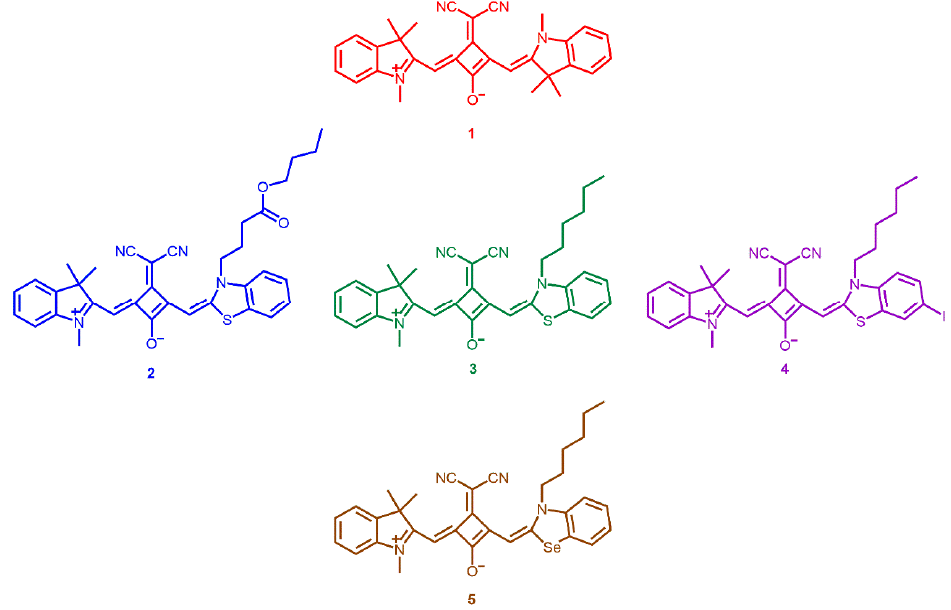
Figure 1. Dicyanomethylene squaraine dyes 1 – 5 involved in the present photodynamic study.